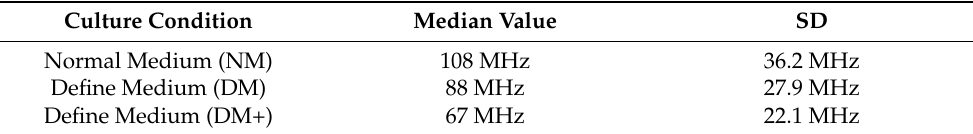
Table 3. Values regarding the crossover frequency measurements of the U87-MG cell